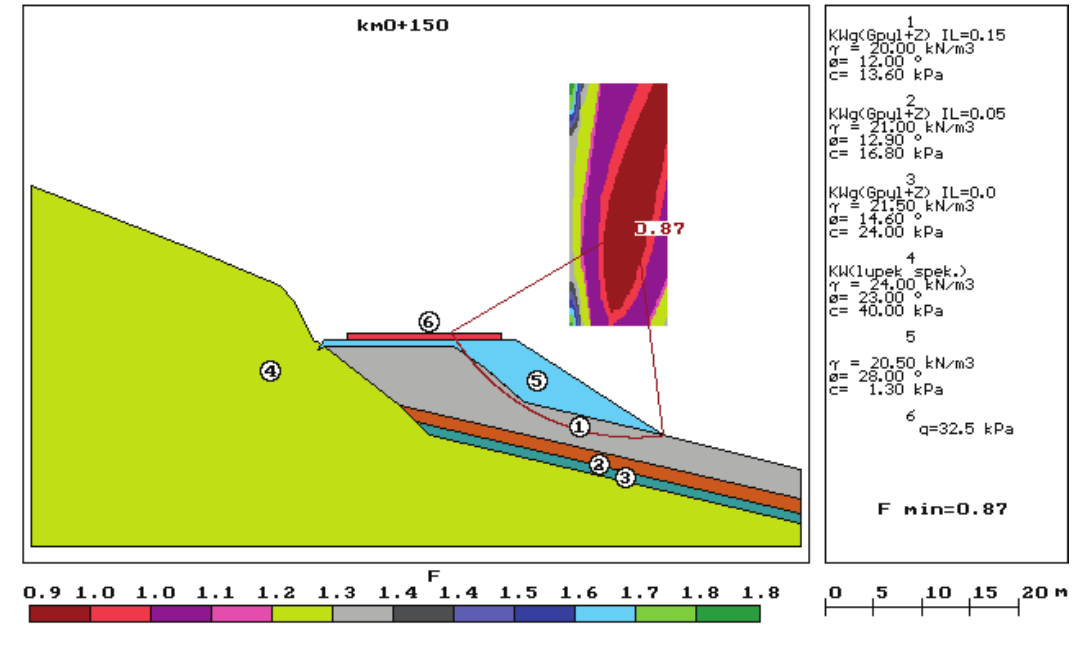
Figure 2. Bolków ring road, cross section of km 0 + 150.02: stability according to EC7 of embankment made of non-cohesive soil.